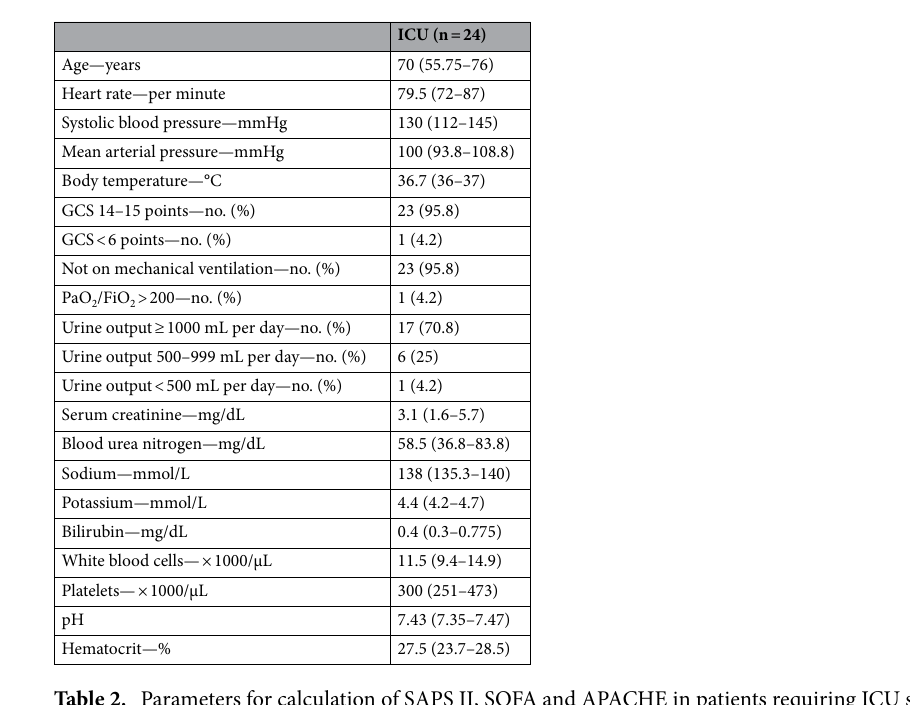
Table 2. Parameters for calculation of SAPS II, SOFA and APACHE in patients requiring ICU supportive care. Continuous variables are expressed as median and IQR, categorical variables are presented as frequency and